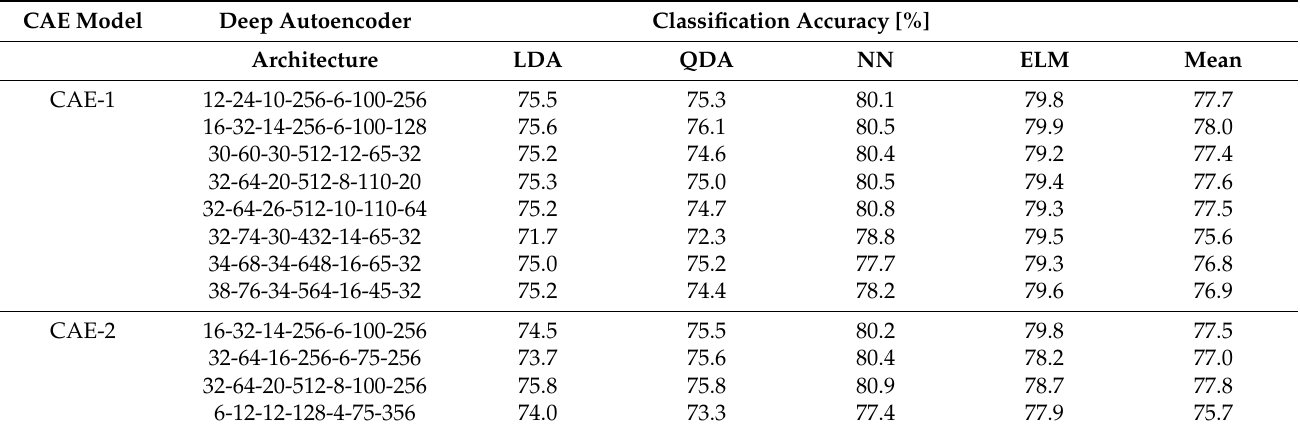
Table 4. Classification results provide classification accuracy, summarized over various CAE configu- rations, and classified by LDA, QDA, NN, and ELM